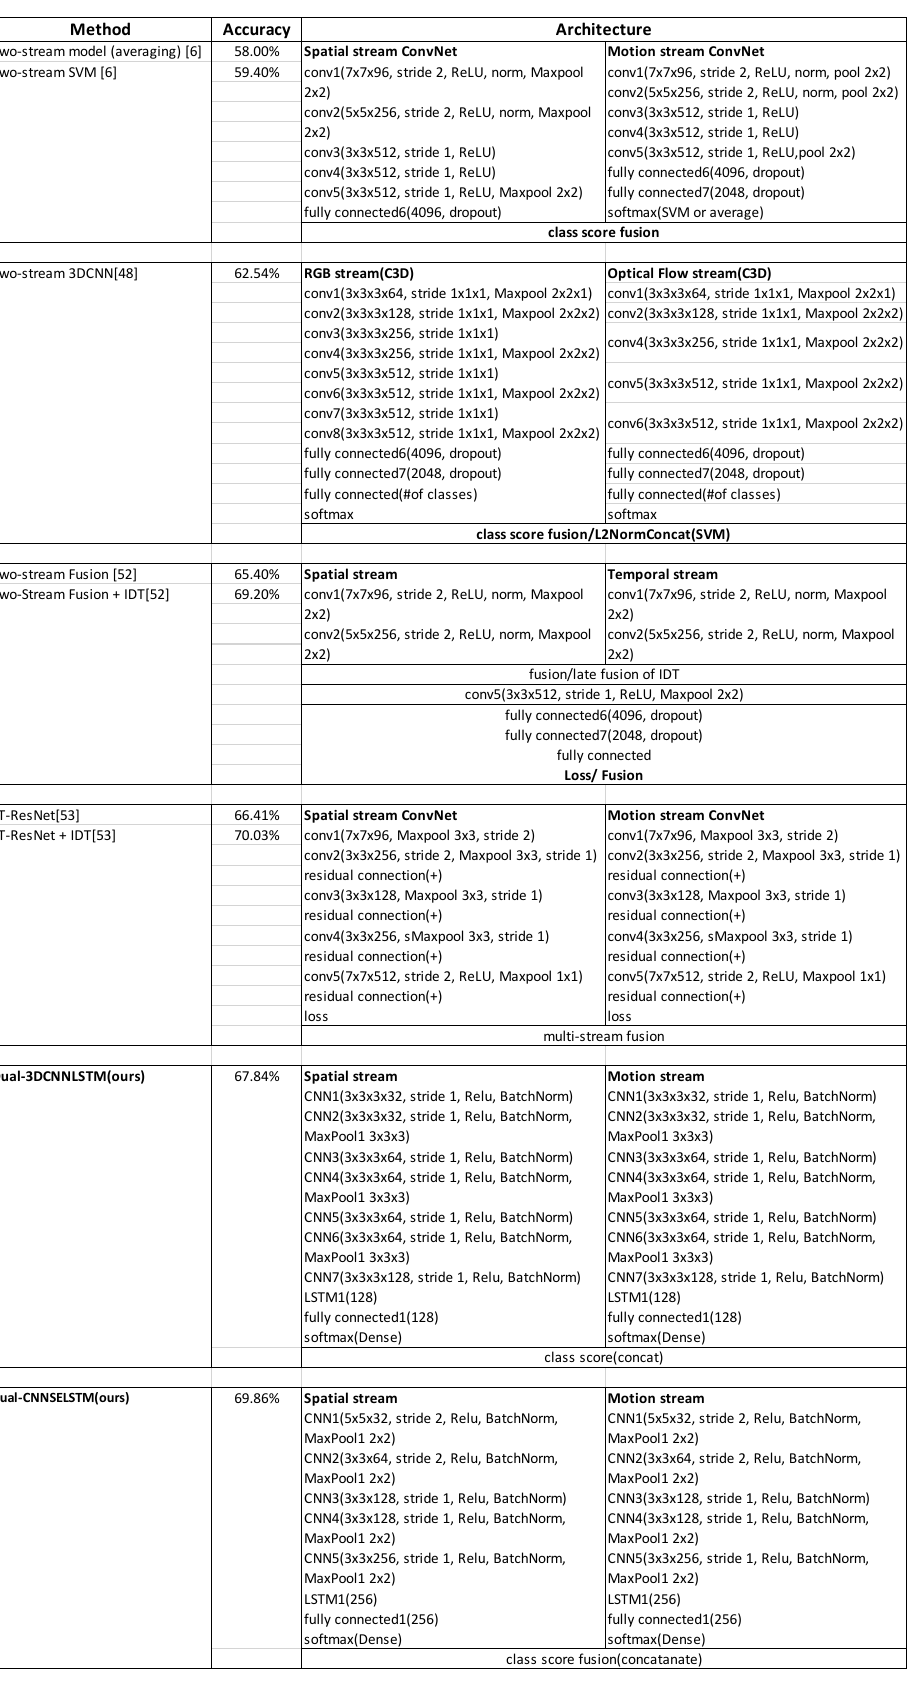
Figure A5. Comparison of the Different Architectures reported in Table 2.